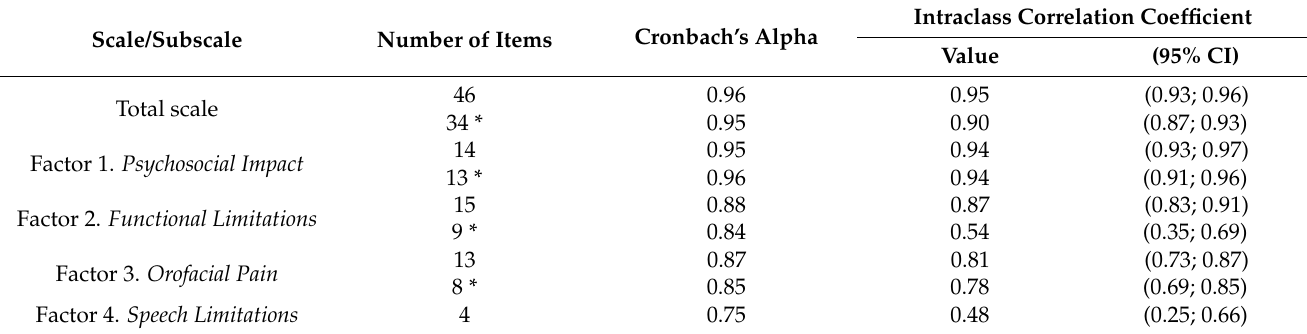
Table 4. Cronbach’s alphas, and intraclass correlation coefficients in the total OHIP-LT and in its subscales defined by the four-factor